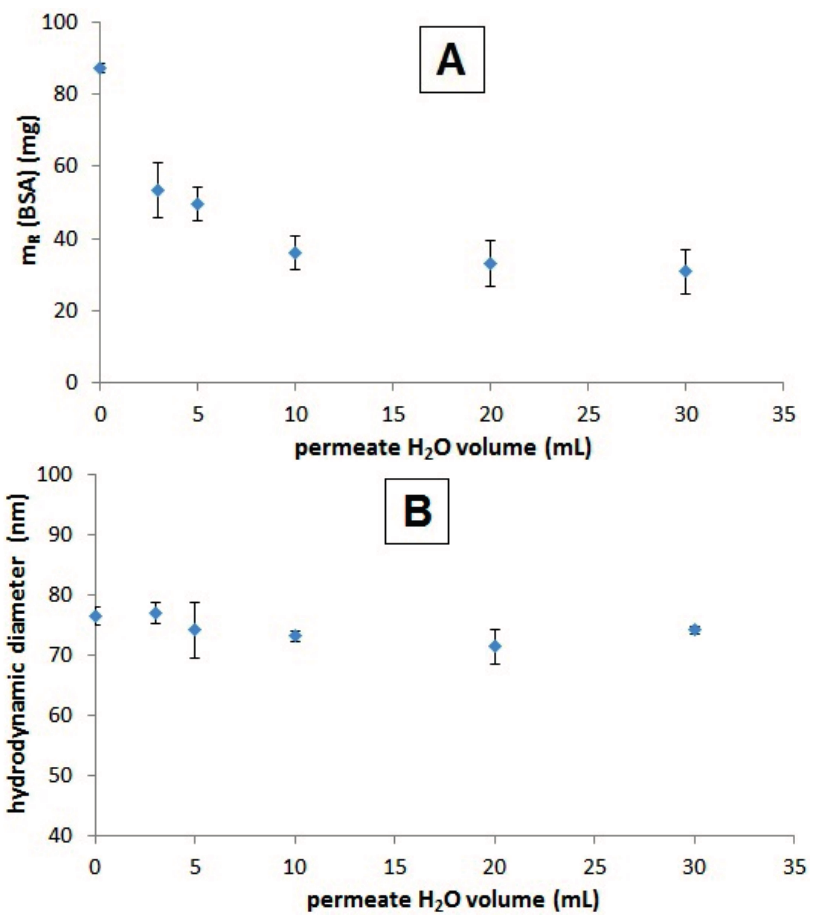
Figure 1. Effect of ultrafiltration on protein content and hydrodynamic aggregate size of SEON LA-BSA . The relative dry mass ( A ) of SEON LA-BSA (V = 5 mL) was calculated after ultrafiltration with different volumes of ultrapure water as the washing agent. The mass displayed is relative to the mass of the precursor SEON LA in order to discriminate the mass of albumin from the mass of the particle cores; ( B ) Photon cross-correlation spectroscopy (PCCS) measurements displayed as volume mean diameter of the samples from ( A ). All measurements were performed in